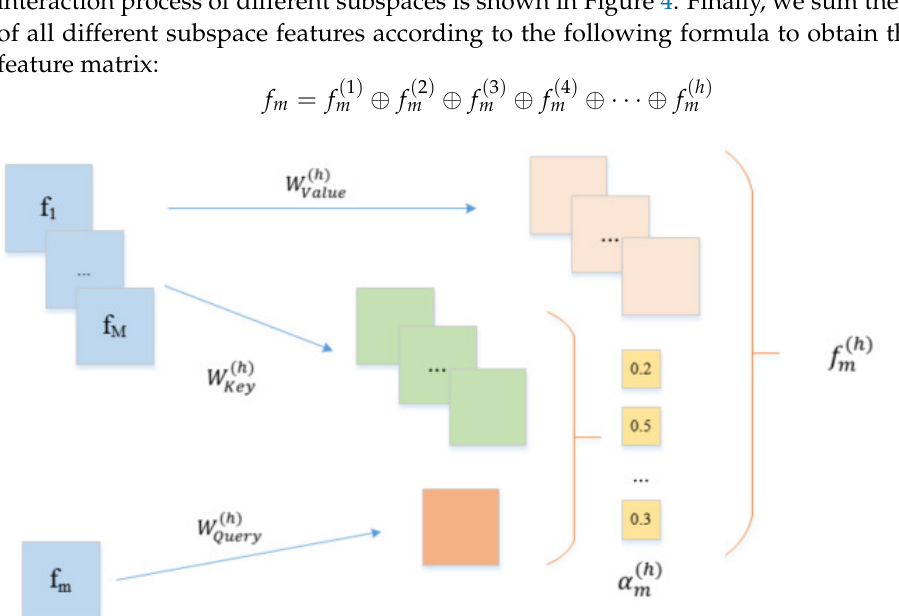
Figure 4. Illustrative diagram of the multi-head attention